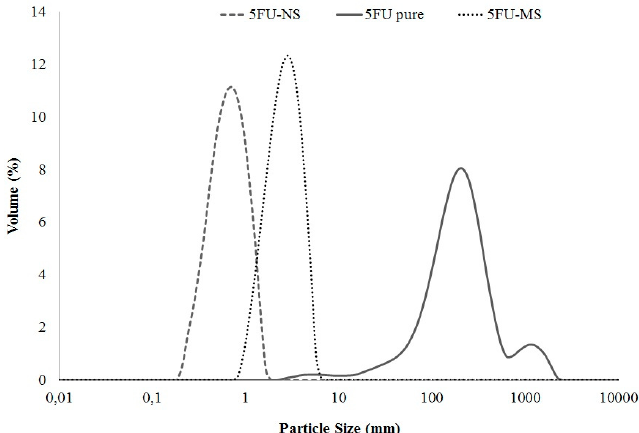
Figure 1. Particle size distribution obtained by laser diffraction (volume average analysis) for the 5FU nanoparticles obtained by piezoelectric atomization (5FU-NS) and 5FU microparticles of